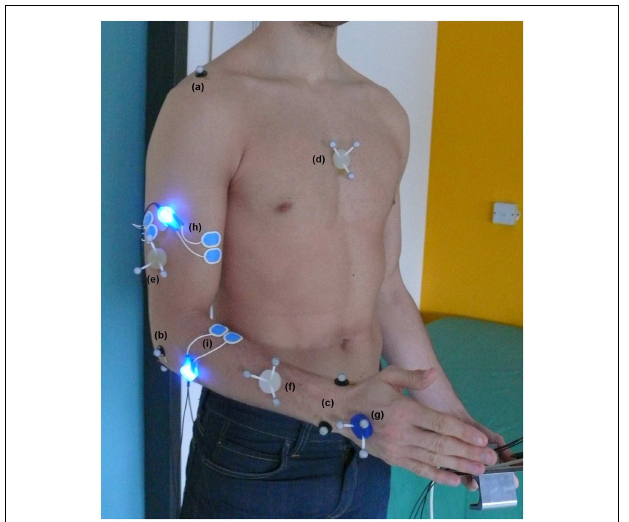
FIGURE 1 | Full marker setup for kinematic analysis of upper extremity including joint marker of acromion (a), elbow joint (b) and wrist (c) as well as marker triplets on the segments thorax (d), upper arm (e), forearm (f), and hand (g). Bipolar sEMG electrode placement including pre-amplifier with blue LEDs of biceps brachii (h) and brachioradialis (i).